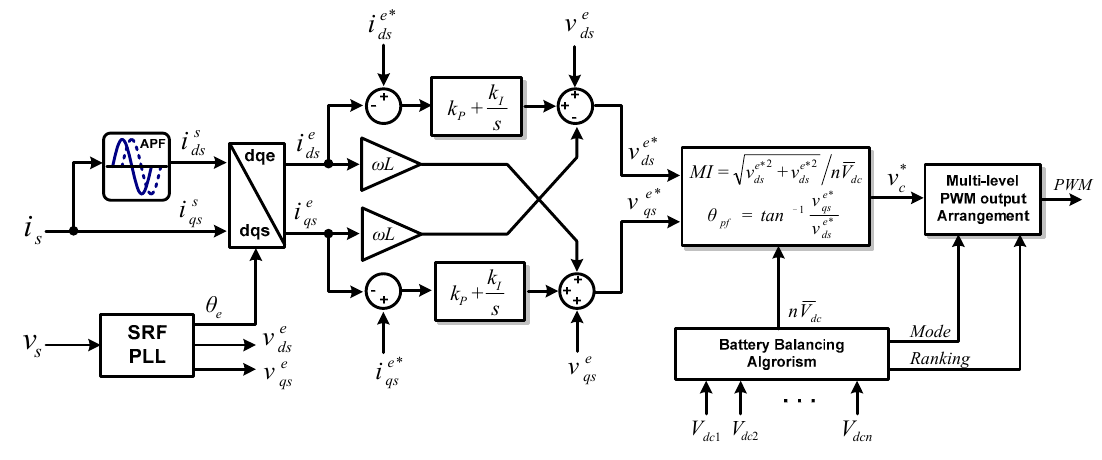
Figure 10. Current controller block diagram.